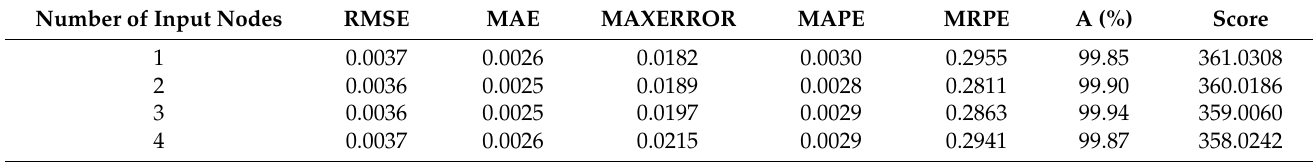
Table 2. Evaluation indicators of LSTM models with different numbers of input nodes.